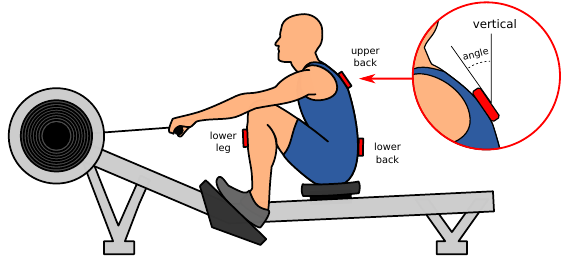
Figure 1: An overview of the experiment with the locations of the sensor modules.